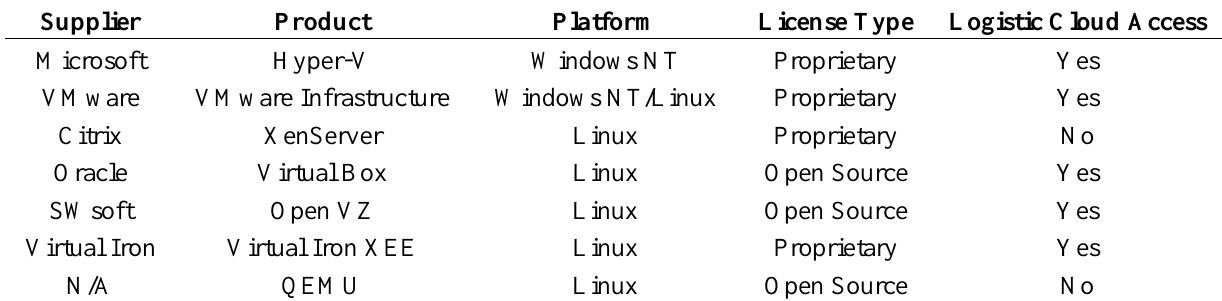
Table 4. Platforms supported by proposed logistic